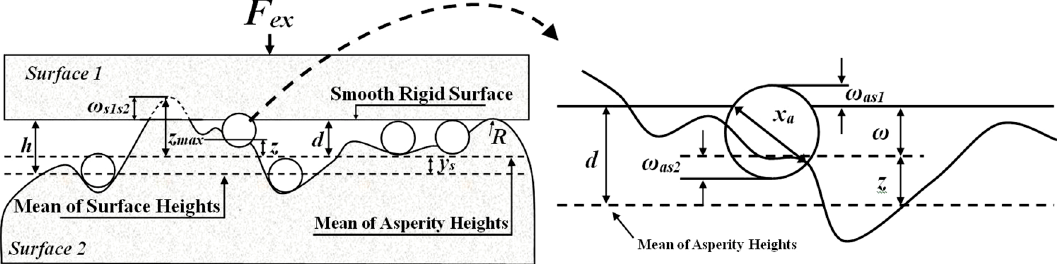
Figure 1. Geometry of three contacting bodies.